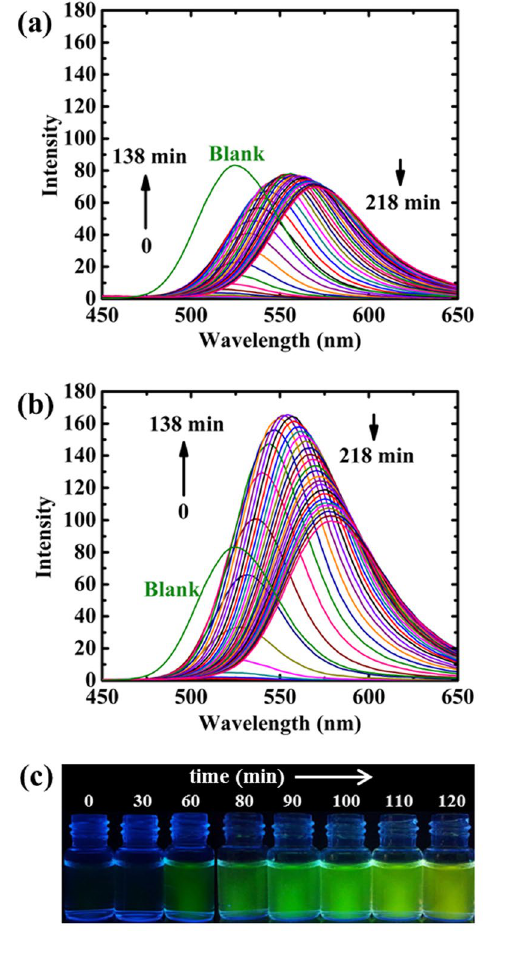
Figure 2. Time-course variation in emission spectra of CdTe QDs upon the addition of ( a ) L-cysteine and ( b ) D-cysteine (The concentrations of cysteine, NaOH, and QDs were 2 mmol L − 1 , 60 mmol L − 1 , and 4.6 µ mol L − 1 , respectively; the excitation wavelength was 340 nm, time interval to record each spectrum was 6 min). ( c ) Fluorescence images of time-dependent luminescence of QDs after the addition of 2 mmol L − 1 D-cysteine and